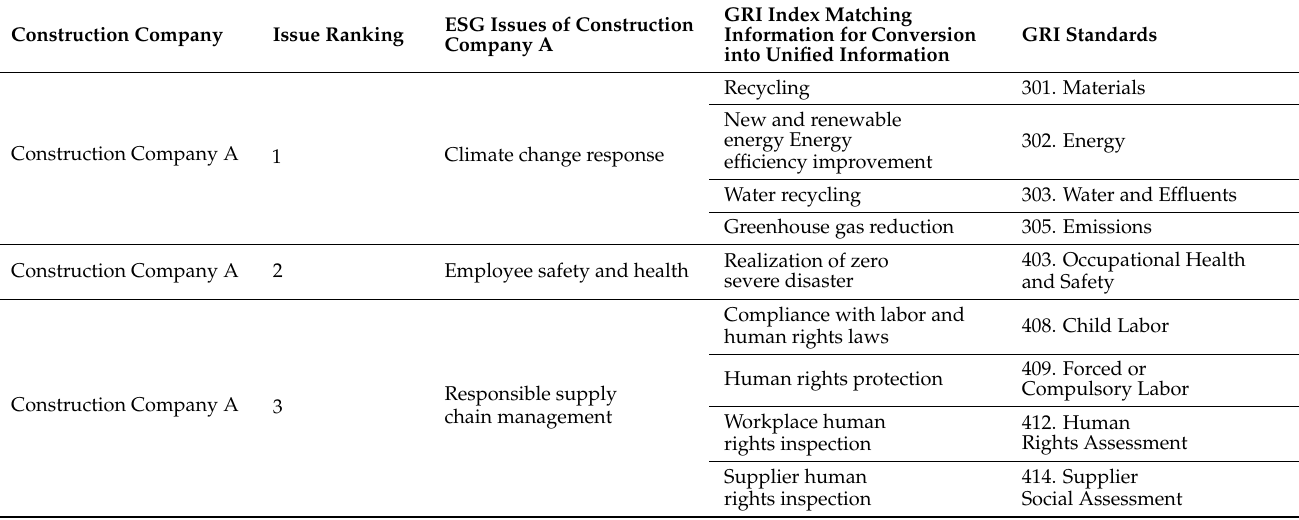
Table 6. An example of GRI conversion table for construction company A in South